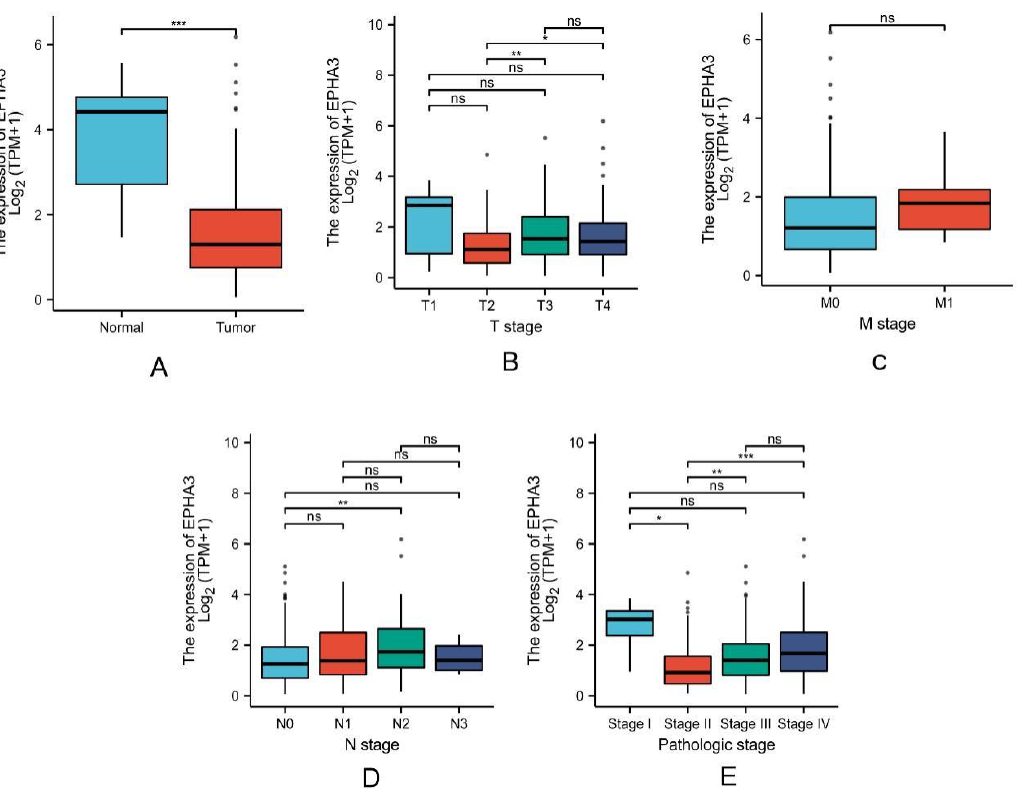
Figure 5. The association between EPHA3 expression and different clinicopathologic data in TCGA- BLCA. The clinicopathologic features included status ( A ), T stage ( B ), M stage ( C ), N stage ( D ), and pathologic stage ( E ). ns stands for no statistical difference, * p < 0.05, ** p < 0.01, *** p < 0.001.